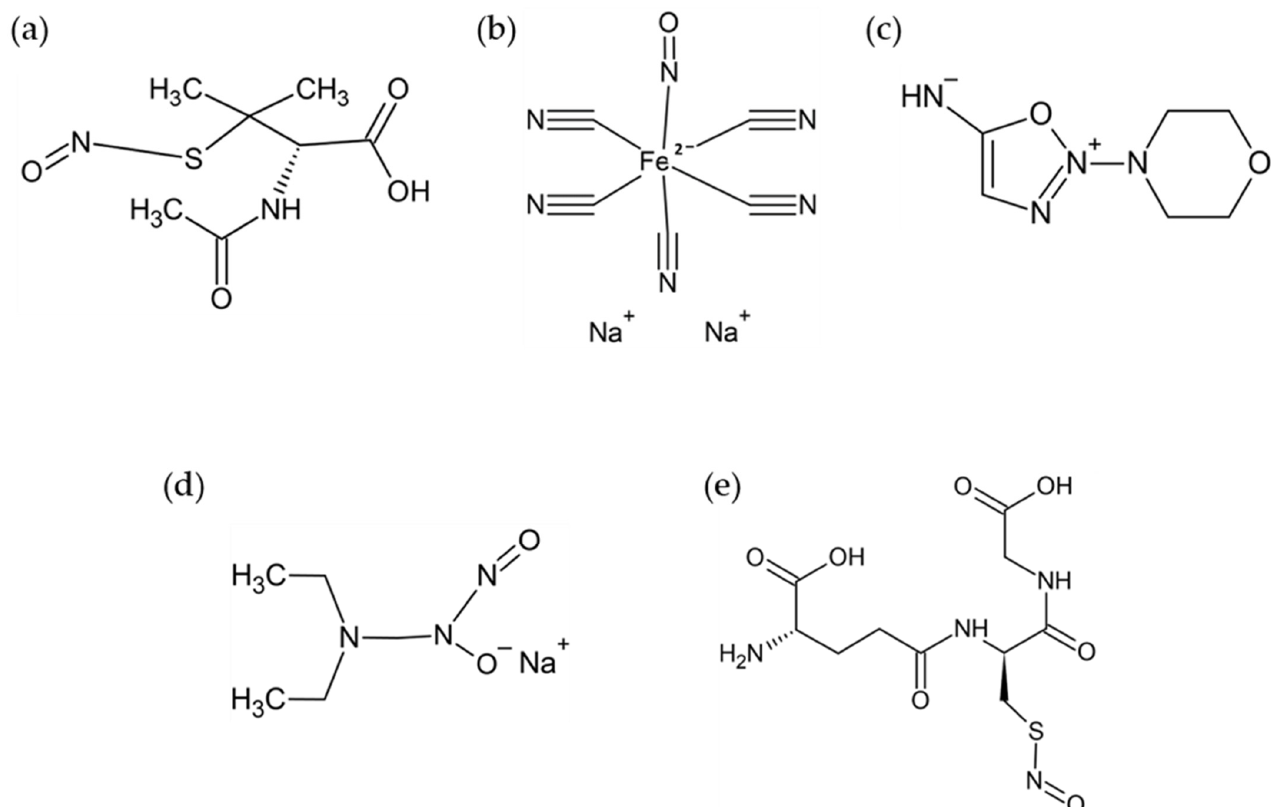
Figure 2. Chemical structures of nitric oxide (NO) donors. ( a ) S-nitro-N-acetylpenicillamine (SNAP), ( b ) sodium nitroprusside (SNP), ( c ) 3-morpholinosydnonimine (SIN-1), ( d ) NONOates, and ( e ) S-nitroglutathione (GSNO).